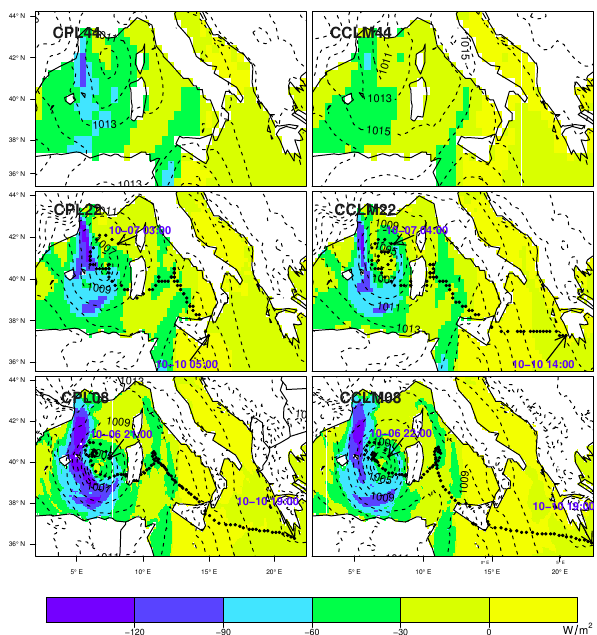
Figure 7. ME08; mean sea level pressure (hPa; dotted contours lines at 2hPa intervals) and sensible heat flux (Wm − 2 ; colored contours at 30Wm − 2 intervals) in the coupled and atmosphere-only (0.44, 0.22, and 0 . 08 ◦ ) simulations on 7 October 1996 at 18:00UTC. Black dots represent track of the